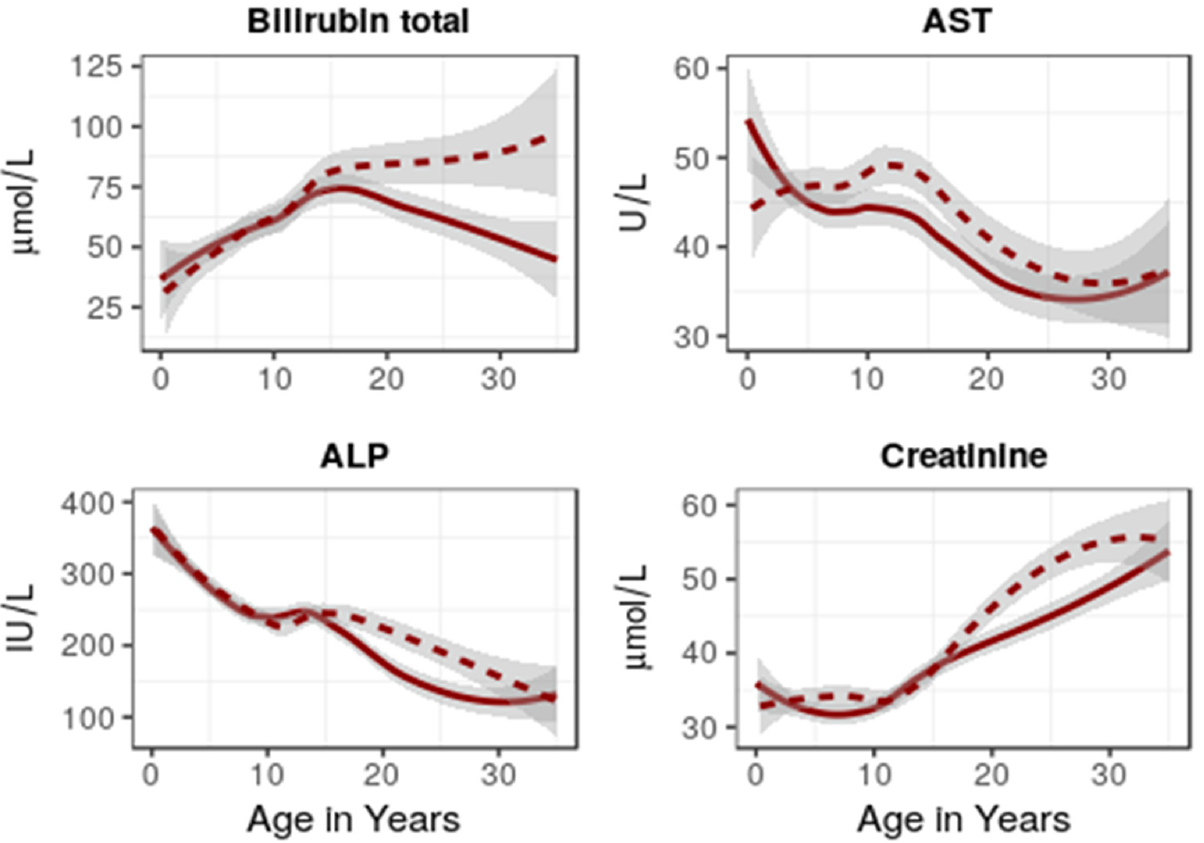
Figure 2. Smoothed mean curves for selected biochemical parameters by sex. Solid lines denote the mean values for females and dashed lines denote the mean values for males.